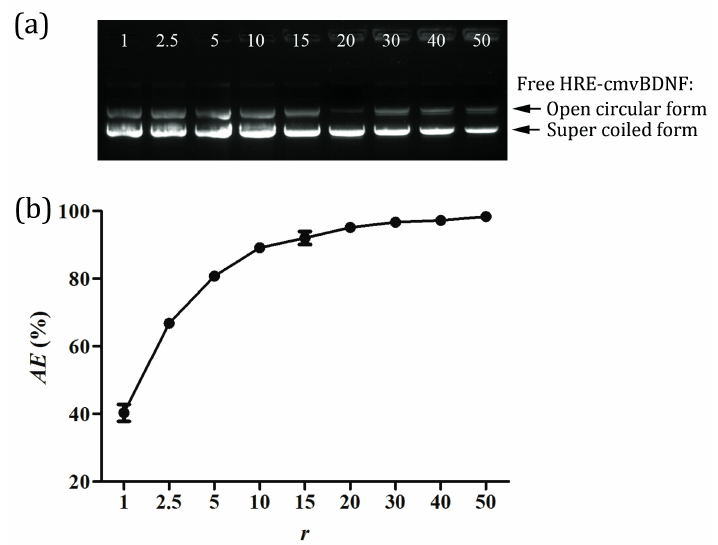
Figure 3. ( a ) Electrophoretic mobility analysis of PS80 PBCA NC/HRE-cmvBDNF by 0.8% agarose gel; a reduction in free HRE-cmvBDNF was observed as the weight ratio increased; and ( b ) adsorption efficiency ( AE ) of HRE-cmvBDNF on PS80 PBCA NC; an AE greater than 90% was reached at a weight ratio of 15:1, no significant gain in AE was found at higher weight ratios. r is the weight ratio of the PS80 PBCA NC to 2 μ g/mL of HRE-cmvBDNF. n = 3; p < 0.001.